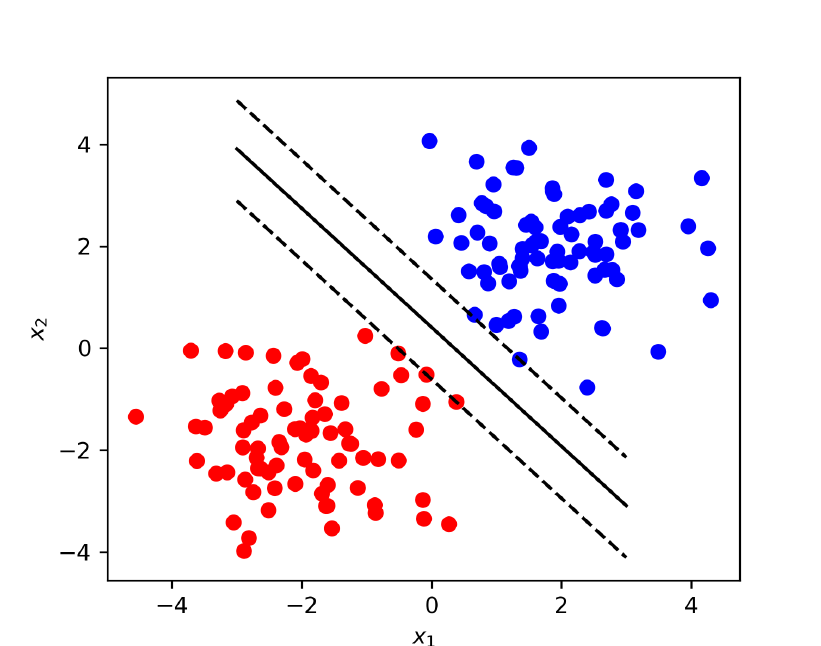
Figure 9. Hyperplane formation for the novel SVM technique.